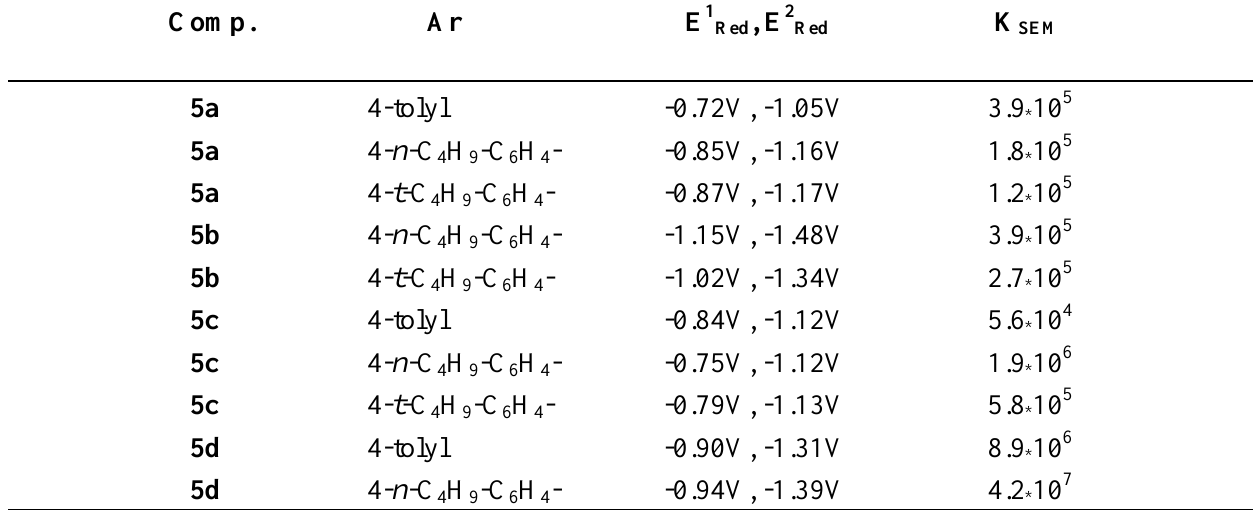
Table 1. Redox potentials and semiquinone formation constants of 4 H -imidazoles 5